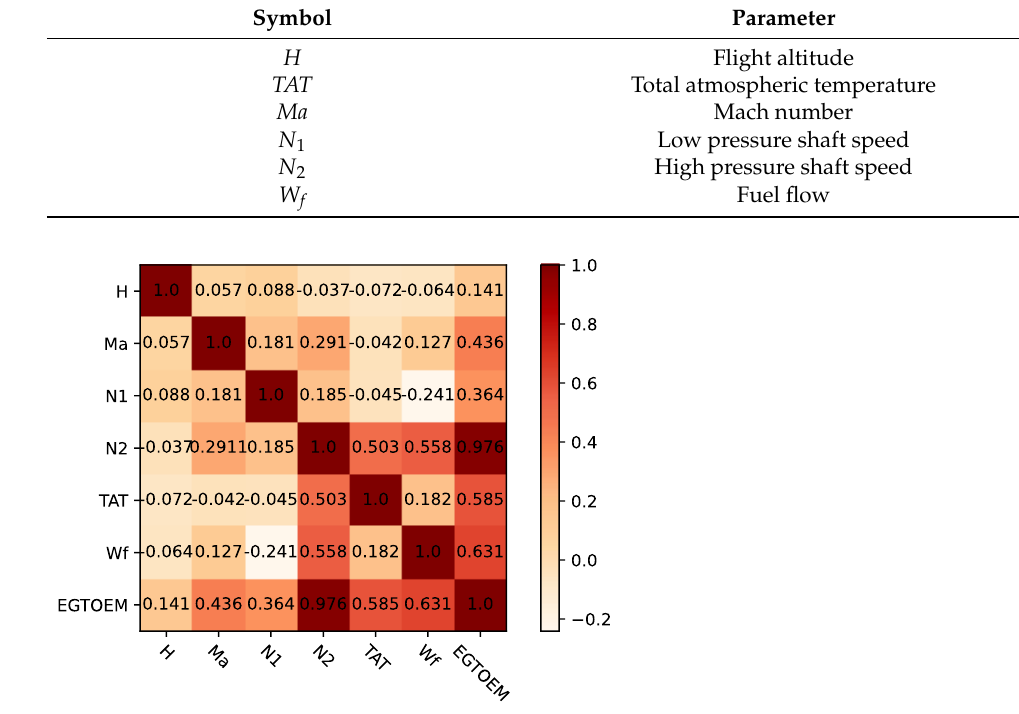
Figure 5. The result of correlation analysis. Table 1. Model input parameters.